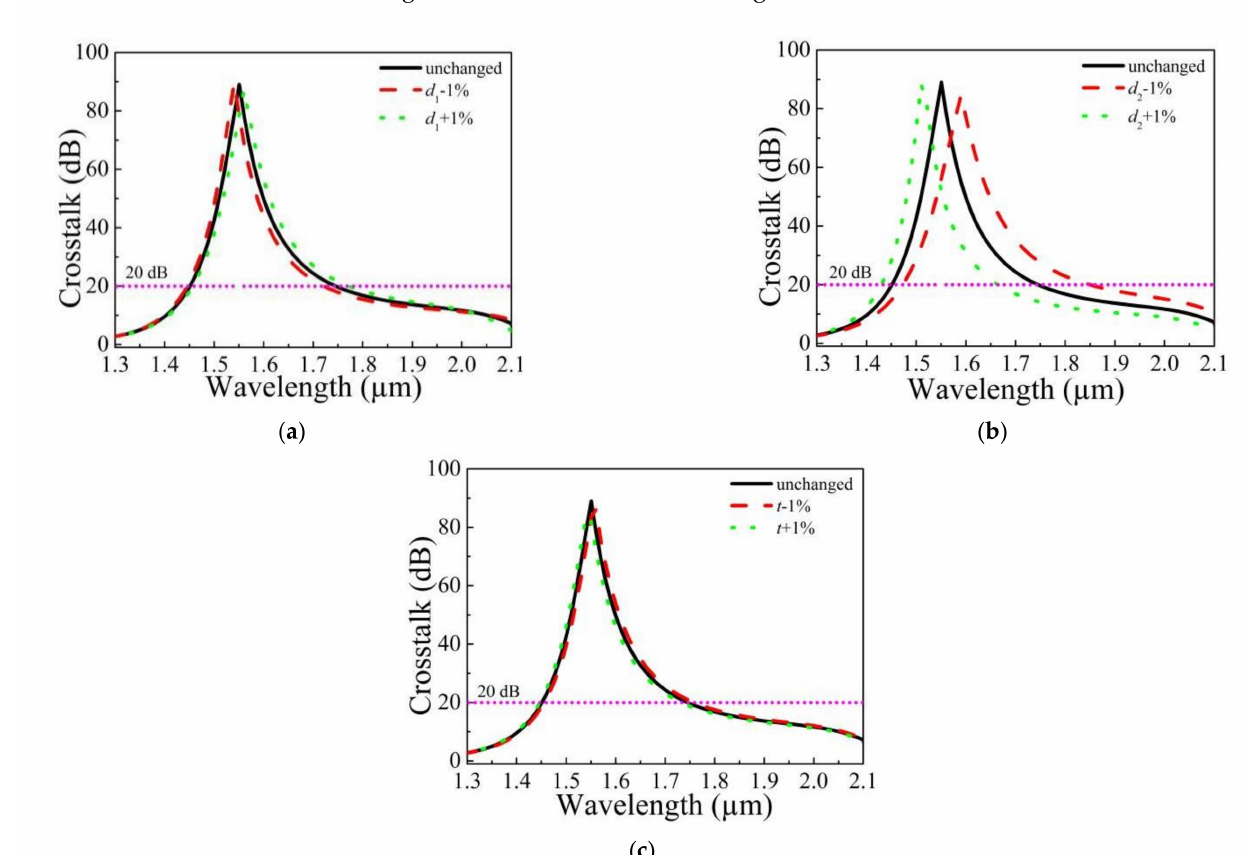
Figure 9. CT value varied with the ± 1% tolerances of ( a ) d 1 , ( b ) d 2 and ( c ) t